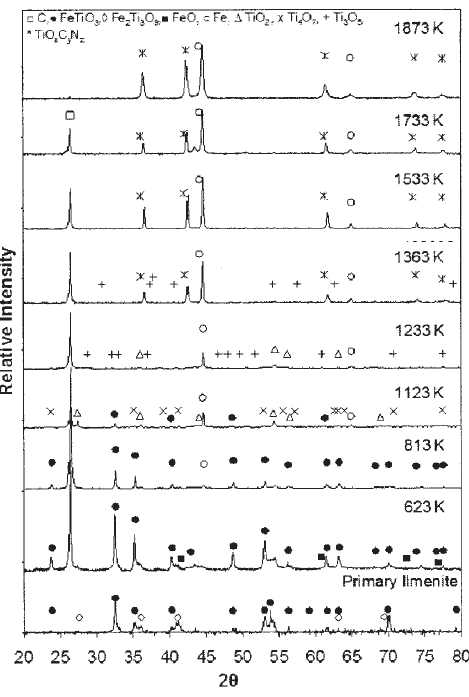
Fig. 3: XRD patterns of primary ilmenite reduced in the H 2 -N 2 gas mixture to the temperatures labeled in Figure 1.